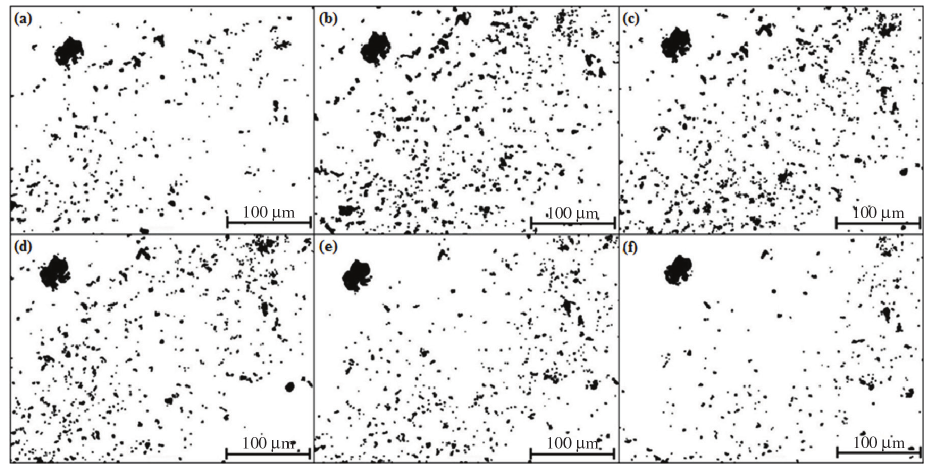
Figure 5. Alignment of the sequence from (a) until (f) of 2D sectioning for the 3D reconstruction of the self-reducing pellet.